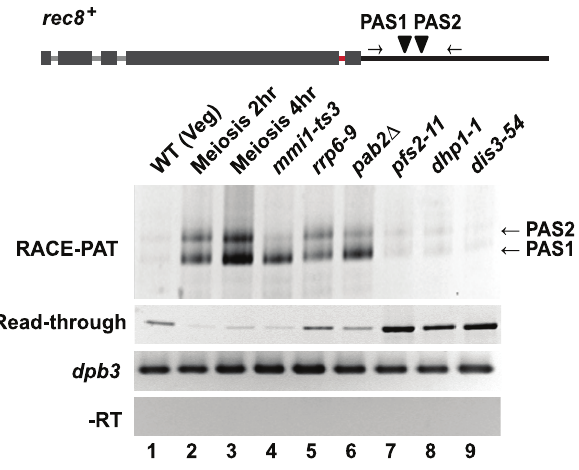
Figure 4. 3’ end processing assays of rec8 . A PCR-based RACE-PAT assay shows the cleavage sites and the amount of polyadenylated rec8 in WT vegetative, meiotic, and mutant strains. This assay does not reflect the length of the polyA tail because most PCR products collapse to the minimum length. Two major cleavage and polyadenylation sites were seen, PAS1 and PAS2 (arrow heads). Each band was sequenced to confirm the assignments. A read-through assay using primers flanking PAS1 and PAS2 (light arrows) yields product representing read-through transcripts (i.e., transcripts progressing past both PAS1 and PAS2). dpb3 is the internal control and -RT shows the absence of